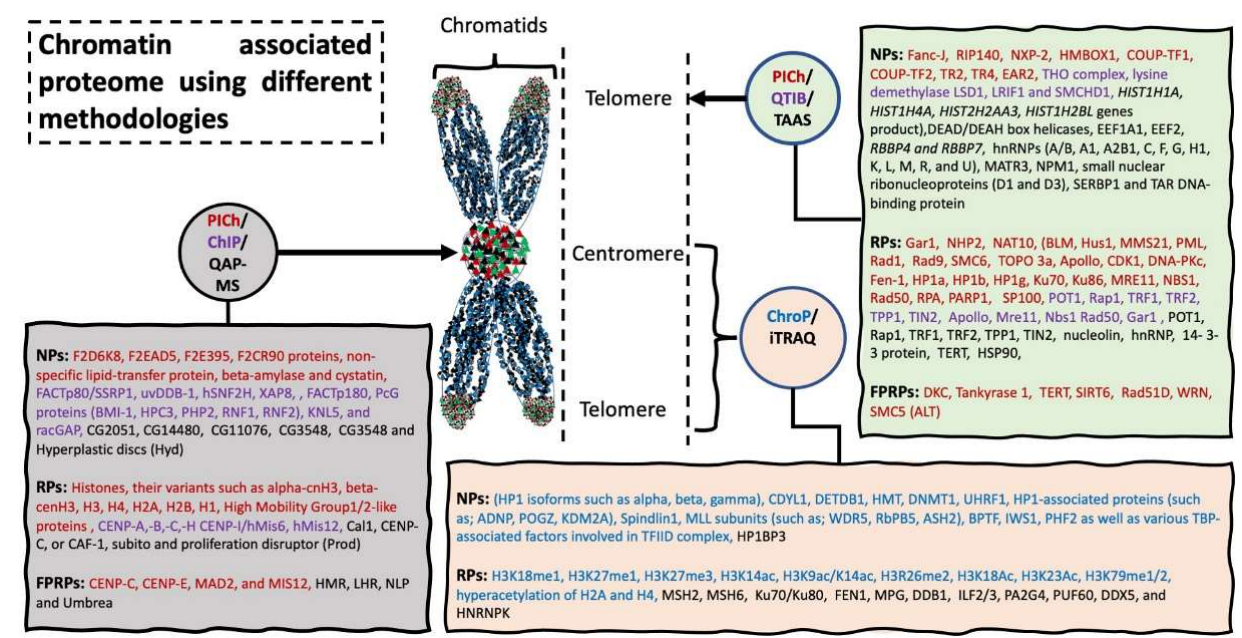
Figure 4. Chromatin associated proteome using different methodologies. Chromatin associated strategies are represented in circles, with arrow indicating the specific target location used for harvesting the sample material. Rectangle shaped represents novel proteins (NPs) and reported proteins (RPs) and protein previously reported but fail to be identified using these methodologies (FPRPs). Methodologies and their respective identified proteomics candidates are listed in same color. Abbreviation: Proteomics of isolated chromatin segments (PICh), tandem affinity associated strategy (TAAS), quantitative affinity purification-mass spectrometry (QAP-MS), chromatin immunoprecipitation (ChIP) (please see extended list in Abbreviations) .